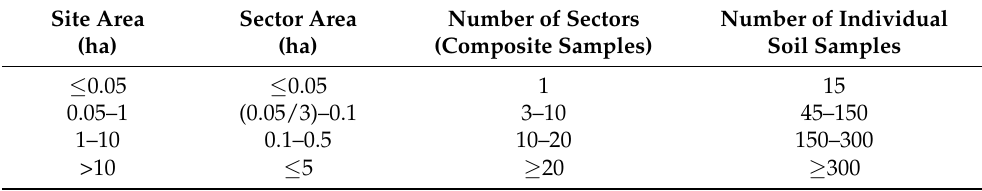
Table 1. Minimal number of soil samples in sampling sectors for residential area [39].